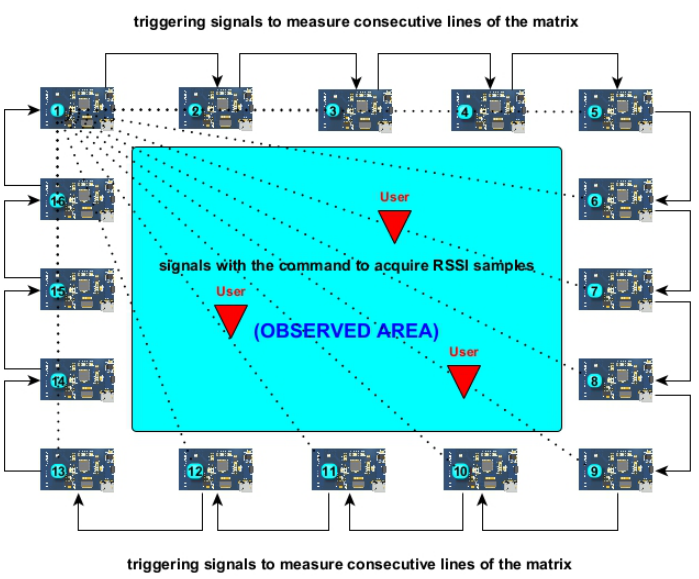
Figure 1. Measurement algorithm used during RSSI data acquisition